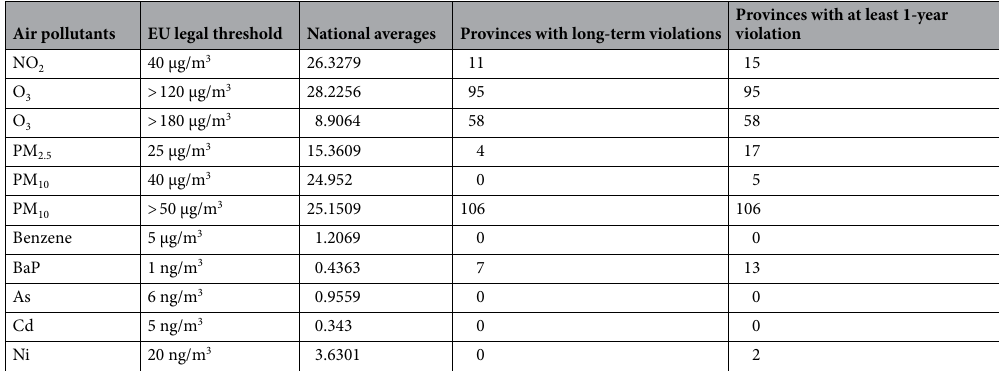
Air pollutants EU legal threshold National averages Provinces with long-term violations